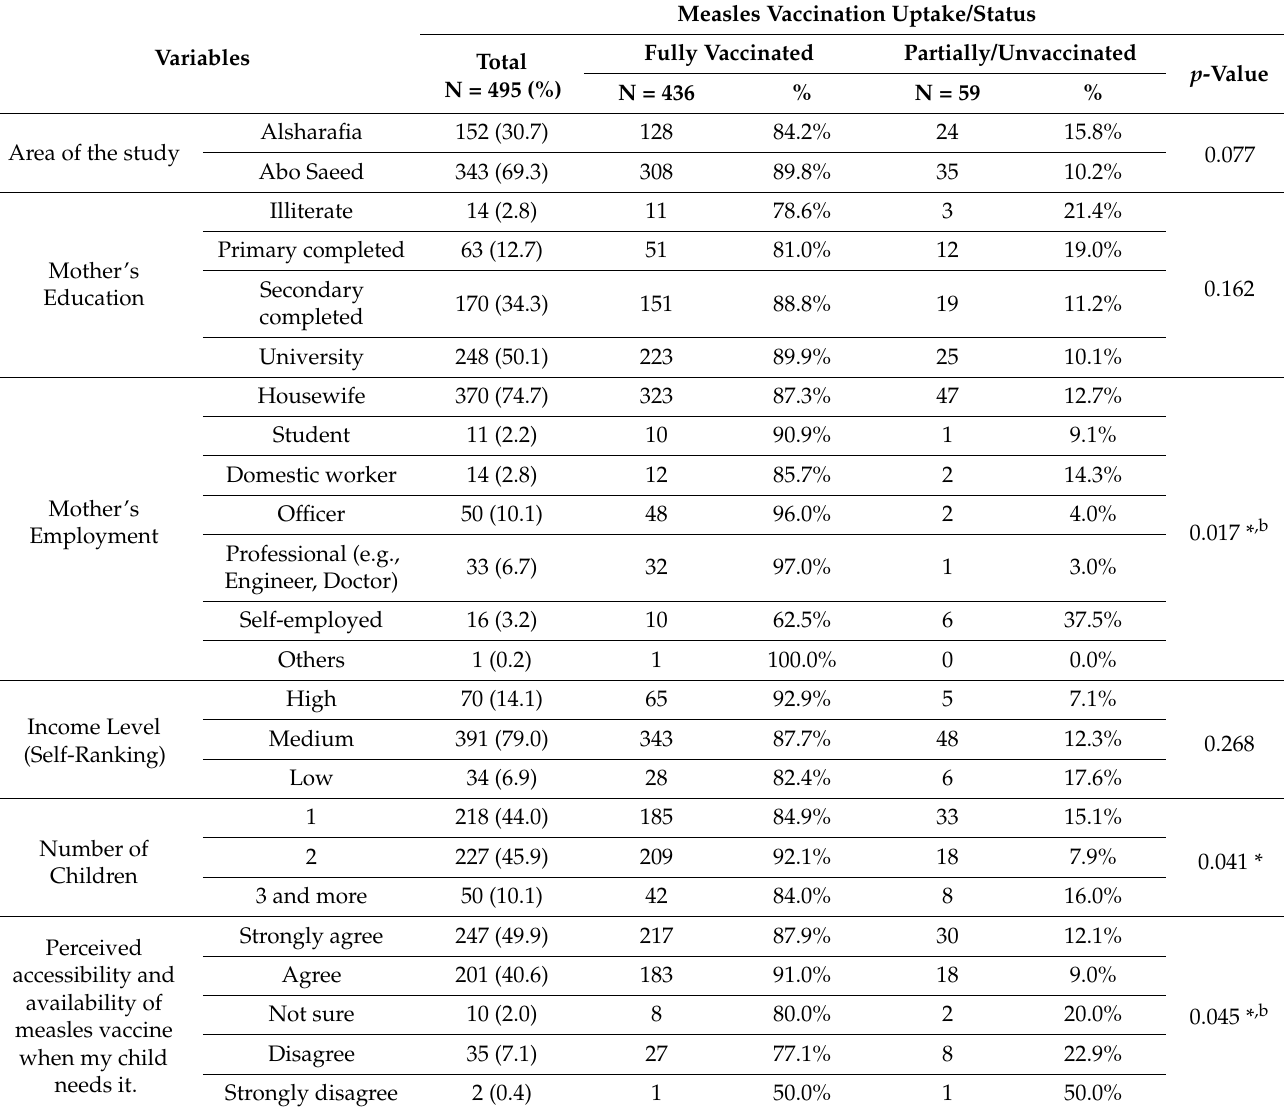
Table 1. Association of the social and behavioral characteristics of the surveyed parents/guardians with measles vaccination status. N =